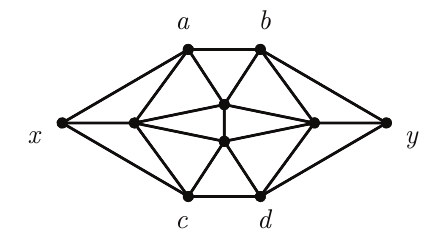
Figure 3. The Birkhoff diamond, a configuration of order 10, with its left- and right-hand endpoints labeled x and y , respectively, and its topmost and bottommost edges labeled ab and cd , respectively.